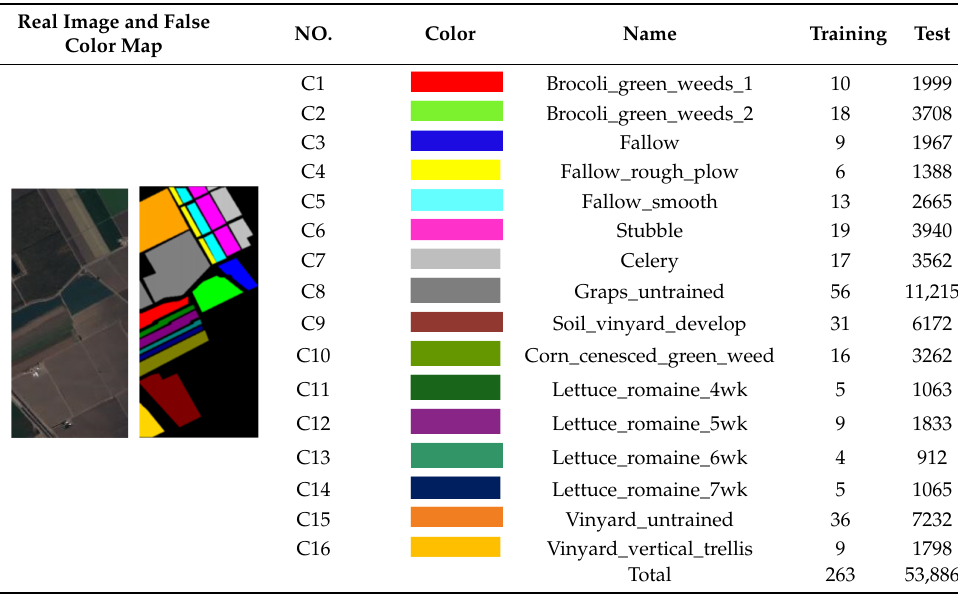
Table 4. Real image, false color map, and number of samples available in the Salinas Valley (SV)